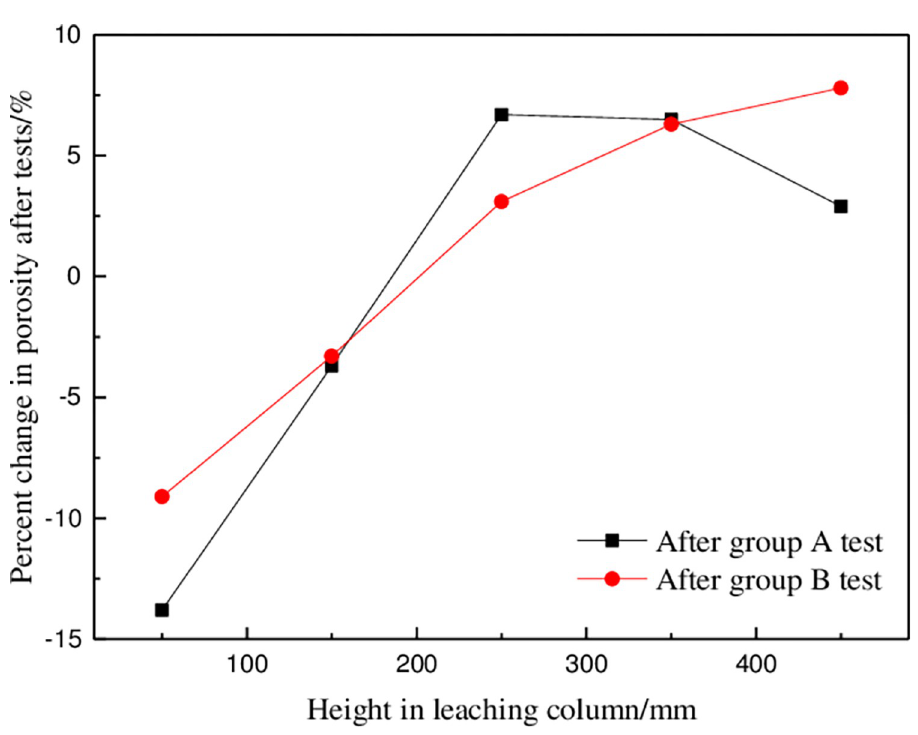
Fig 7. Schematic diagram of percentage change of ore porosity after group A and B